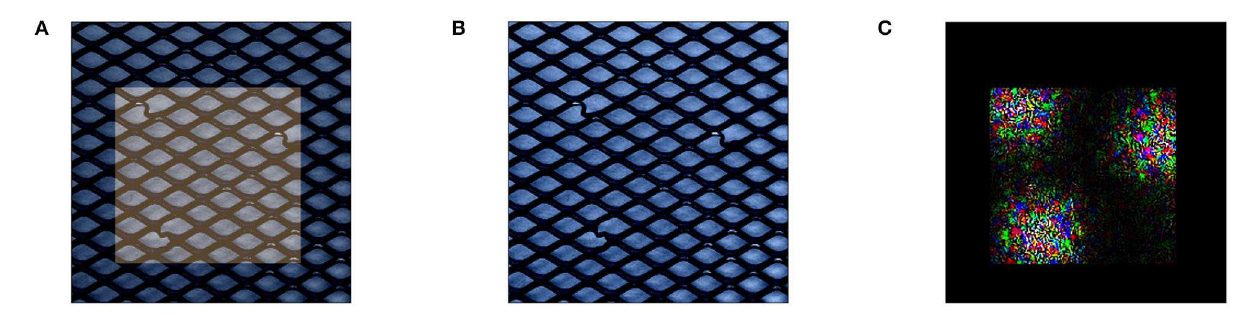
FIGURE4 Perturbation with Equation (11) on MVTec: when perturbing x while keeping the dark area K shown in (A) , Equation (11) generates data point x ′ lopt that is visually indistinguishable from x (B) . We visualize the amplified change in pixel values in (C) .